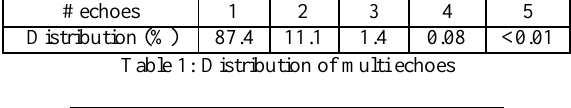
Table 1: Distribution of multi echoes